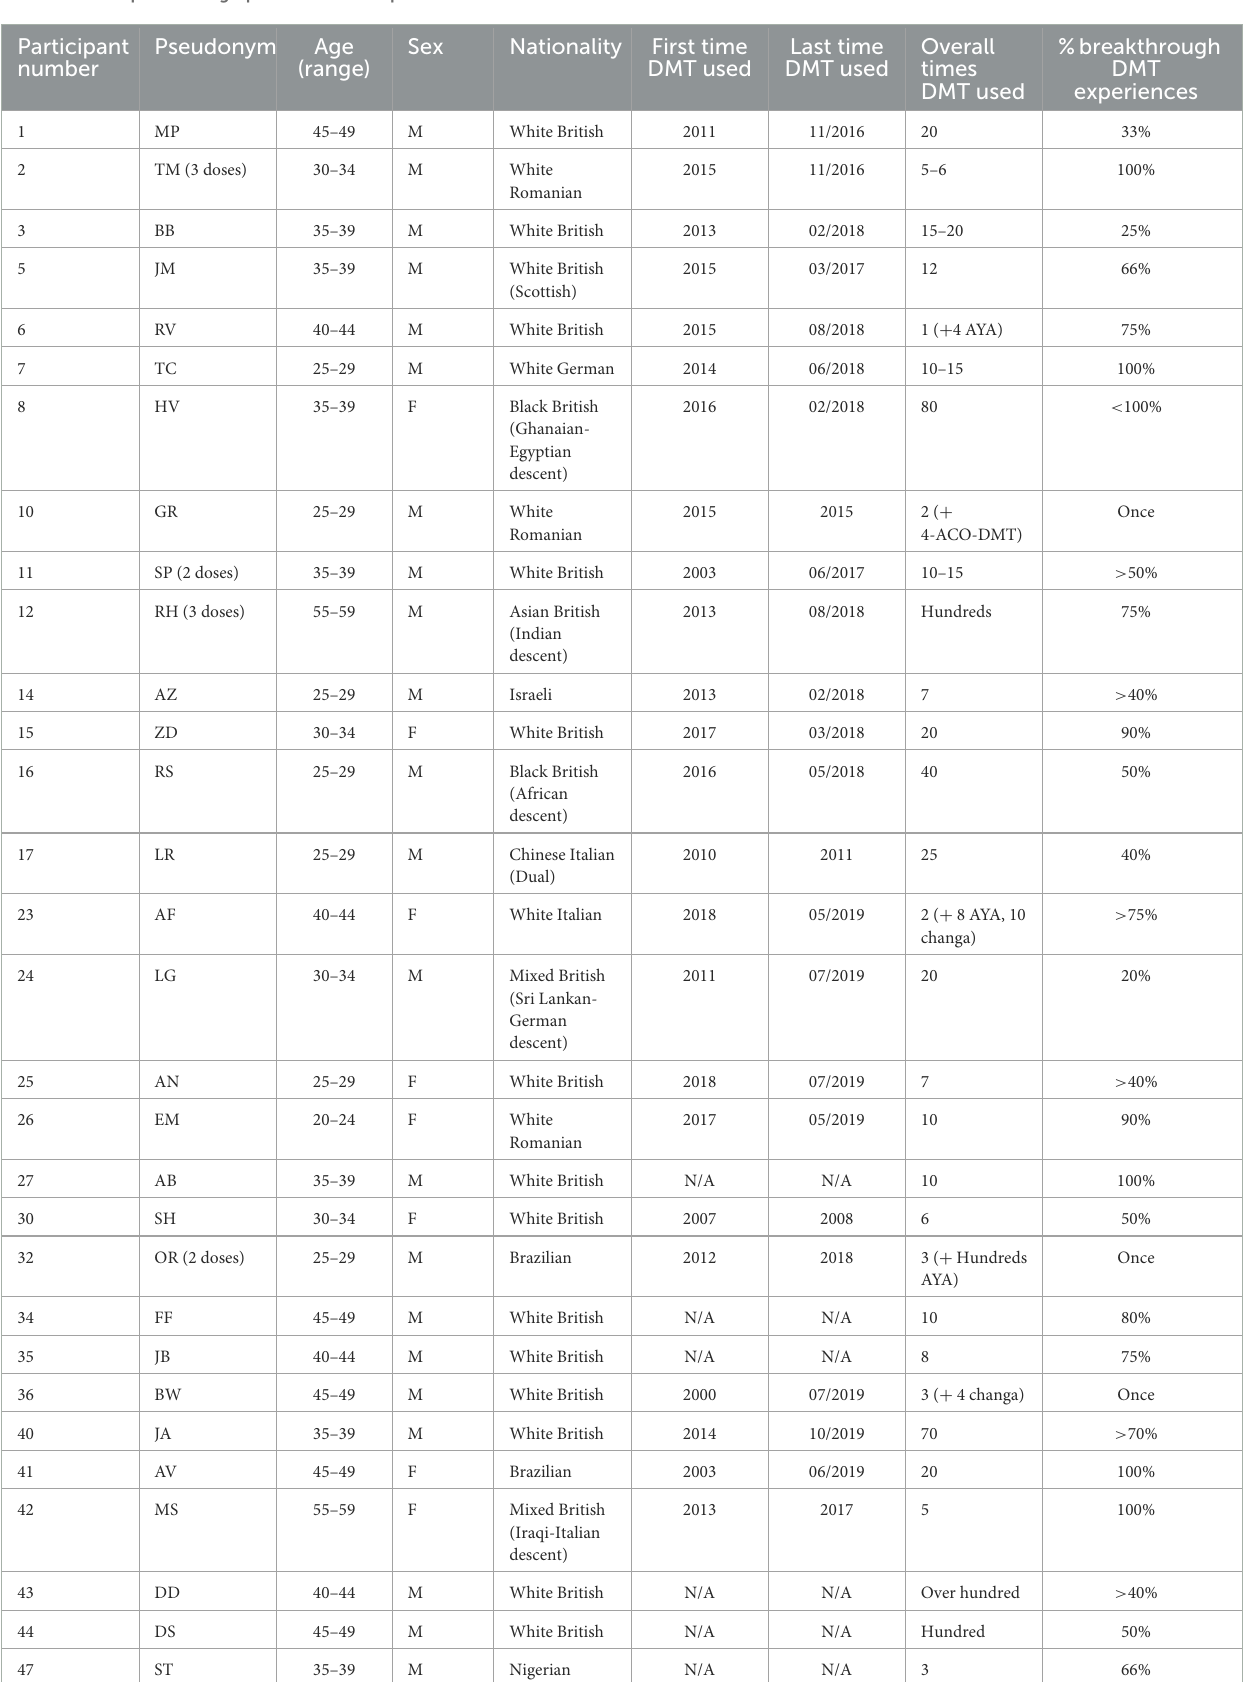
TABLE 1 Participant demographics and DMT